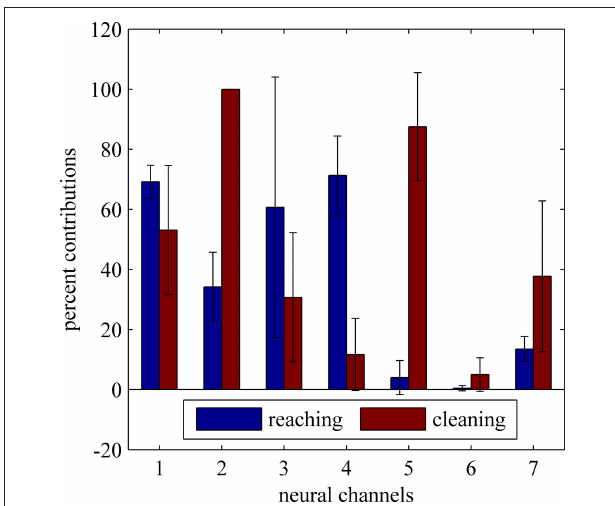
Figure 9 | relative contributions of neural channels to the independent components during two different behaviors. reaching for food and face cleaning. See text for the analysis details. The distribution of percentages across the neural channels presents distinctly different patterns for each